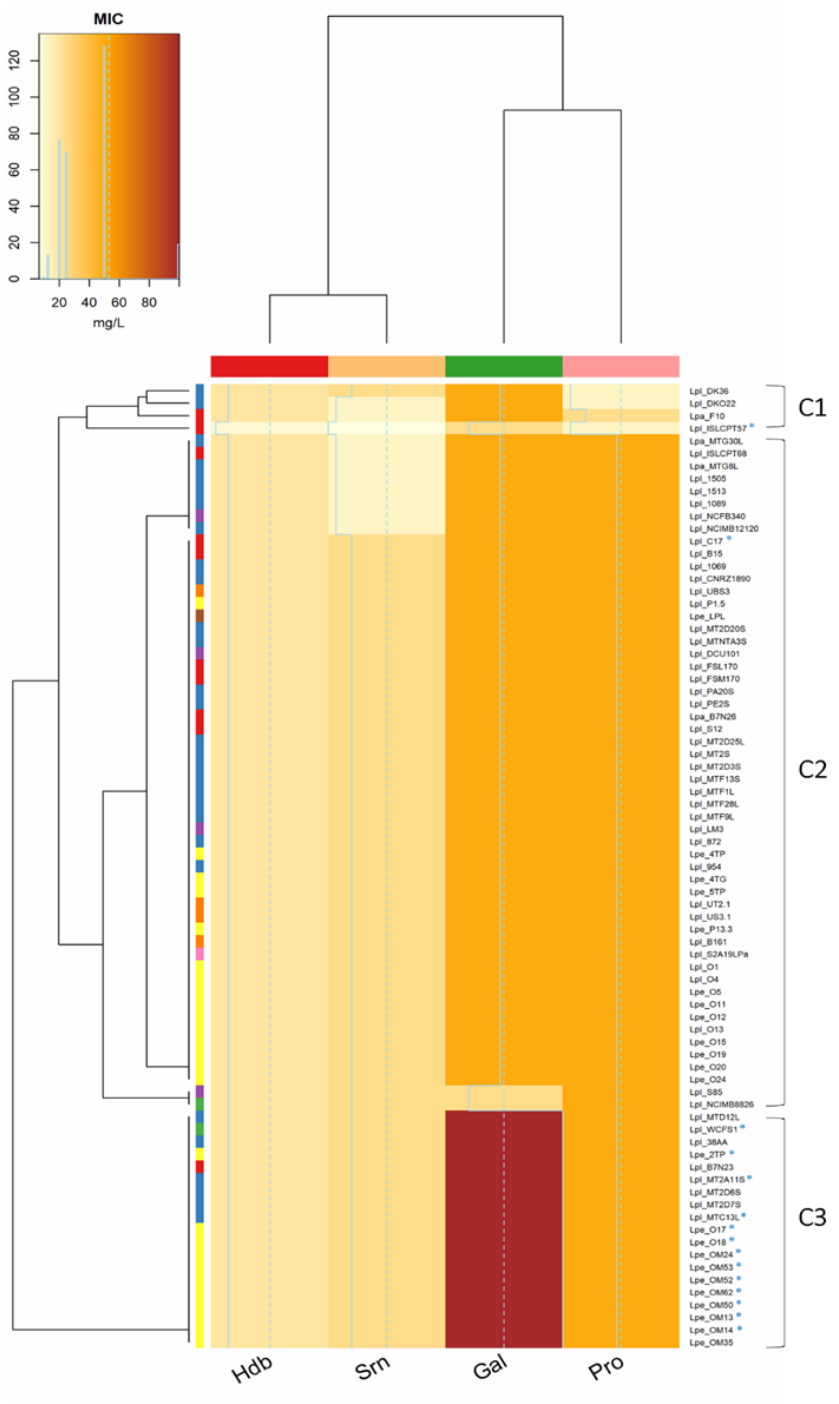
Figure 2. Minimum inhibitory concentration (MIC, mg/L) of 4-hydroxybenzoic (Hdb, 40–2.5 mM), syringic (Srn, 25–1.56 mM), gallic (Gal, 100–6.25 mM) and protocatechuic (Pro, 50–3.12 mM) acids. Phenolic compound concentration is defined by different colours shades, from yellow (0 mg/L) to red (100 mg/L). Rows of the dendrogram: LAB species: Lpl, Lpb. plantarum , Lpa, Lpb. paraplantarum , Lpe, Lpb. pentosus ; isolation source: vegetables (violet), sourdoughs (blue), olives and derived products (yellow), dairy products (red), wine (orange), human sources (green), meat products (brown), unknown sources (pink). Rows of the dendrogram show similarity relationships between strains based on phenolic compounds tolerance. Columns of the dendrogram show the similarity among the effect of phenolic compounds on Lactiplantibacillus